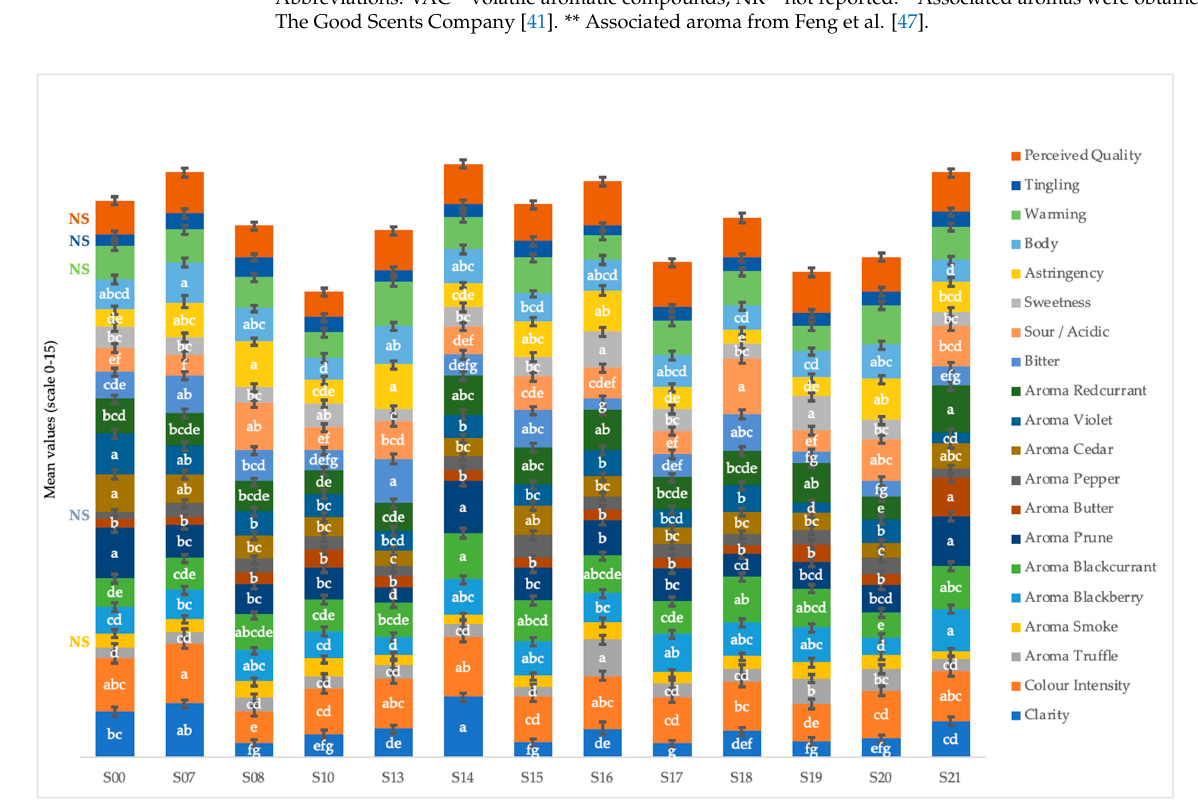
Figure 4. Mean values of sensory descriptors for Shiraz vertical vintages. Significant differences are denoted by different letters (a–g) based on ANOVA and post hoc test Fisher’s least significant difference (LSD) at α = 0.05. Sample abbreviations are displayed in Table 1. Error bars = standard error (range: 0.32–1.82).